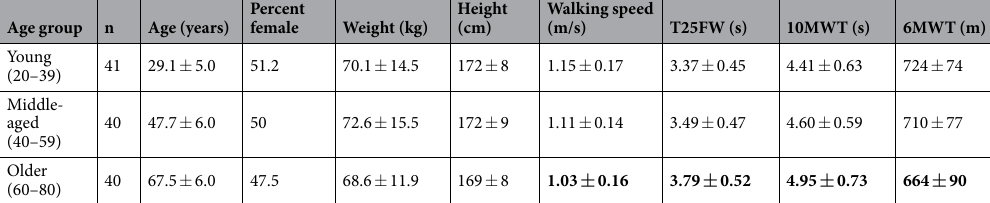
Table 1. Demographics and walking ability in the three age groups. Group comparisons were made using one-way ANOVA with post-hoc t-tests corrected for multiple comparisons (Bonferroni). Values given are means ± standard deviation. Bold type indicates significant difference compared to both other age groups at